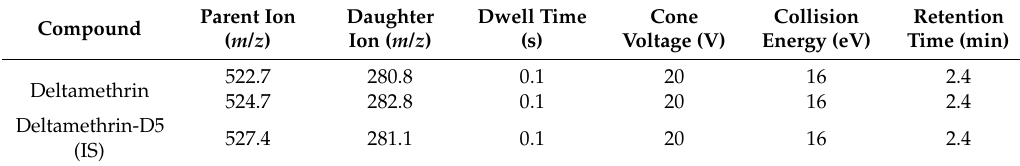
Table 1. Multiple reaction monitoring (MRM) conditions for deltamethrin and deltamethrin-D5 (IS).